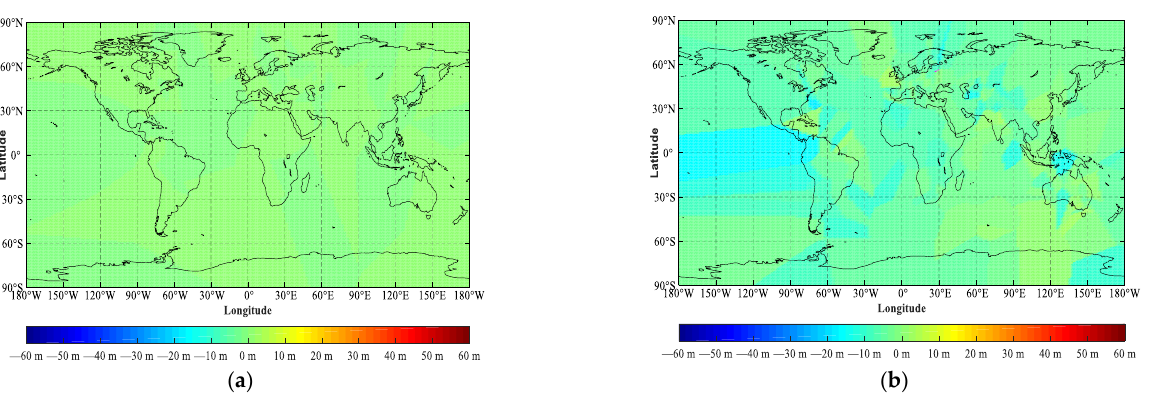
Figure 6. Global test statistics of IICODM based on ( a ) GPS and ( b ) BDS observation under case1 and case2. Table 5. Statistics of IICODM test statistics and RMSE (m).